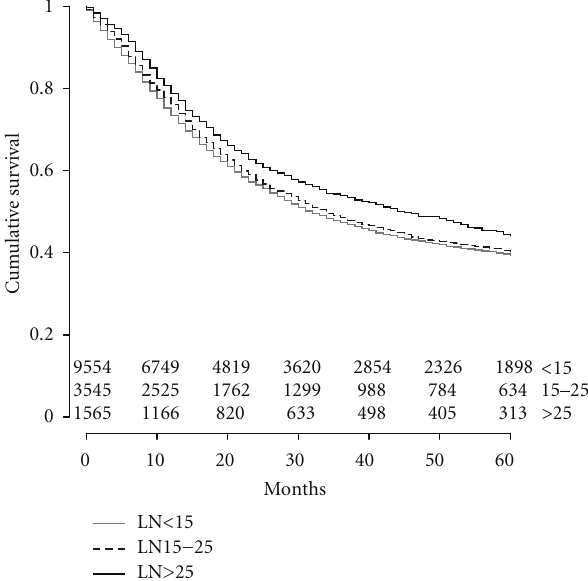
Figure 2: Kaplan Meier curve of disease specific survival by lymph node resection. Lymph node